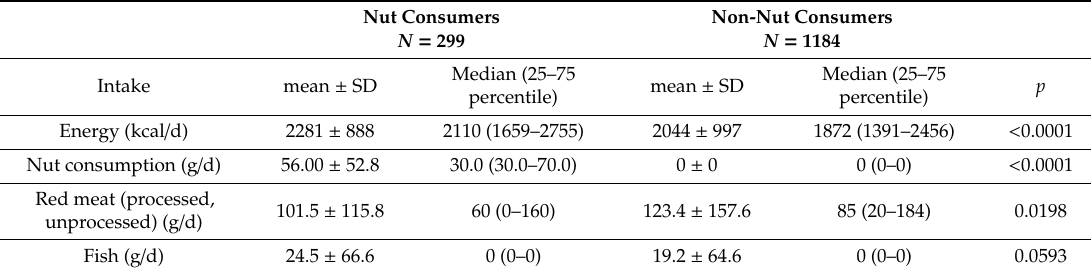
Table 2. Energy, food intake, and diet quality in nut-consumers vs. non-nut